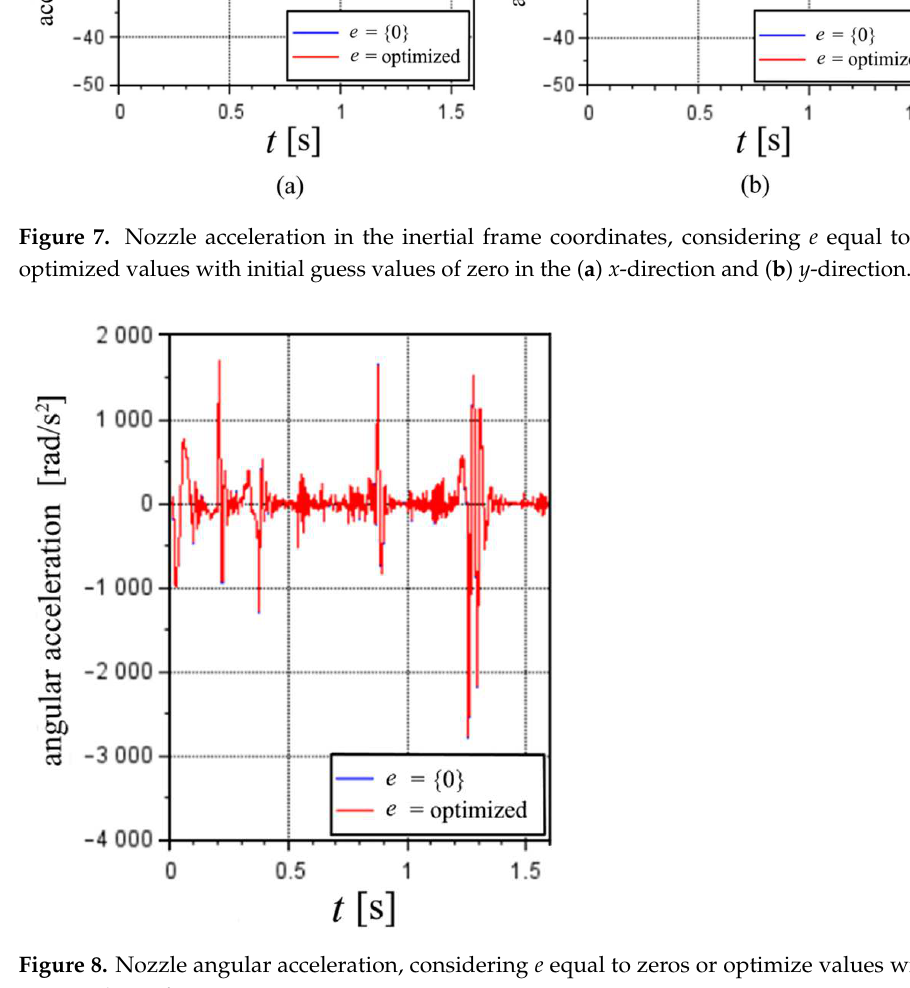
equal to zeros or optimize values with initial :